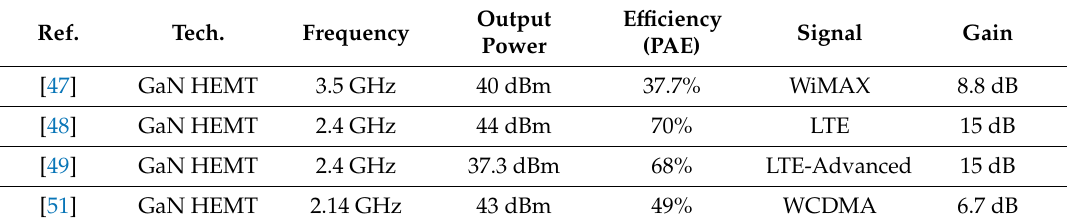
Table 5. Performance comparison of Class-F − 1 / F Doherty